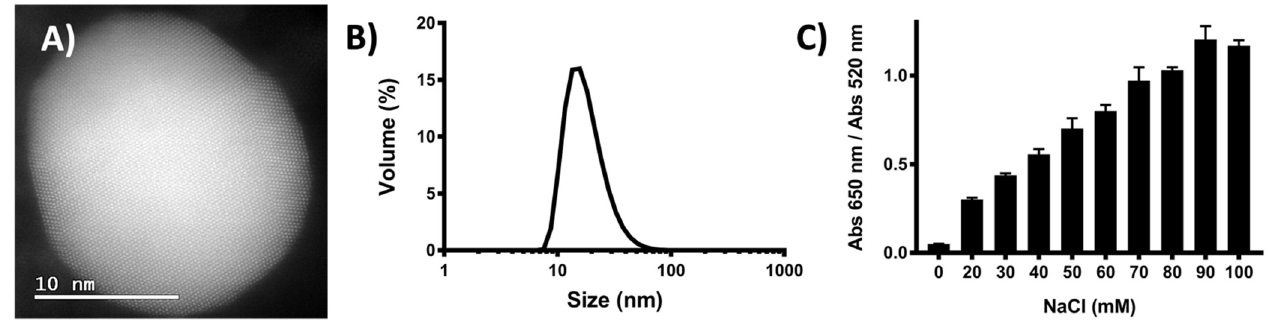
Figure 1. Characterization of non-functionalized gold nanoparticles (nfGNPs). ( A ) Quasispherical nfGNPs were directly visualized by HAADF-STEM (scale bar = 10 nm). ( B ) Hydrodynamic diameter of nfGNPs as determined by DLS. ( C ) Salt-induced aggregation of nfGNPs. Increasing NaCl concentrations were used to determine the minimum concentration required to trigger nfGNP aggregation (color shift from 650 to 520 nm). Bars represent the mean and standard deviation of three independent experiments.